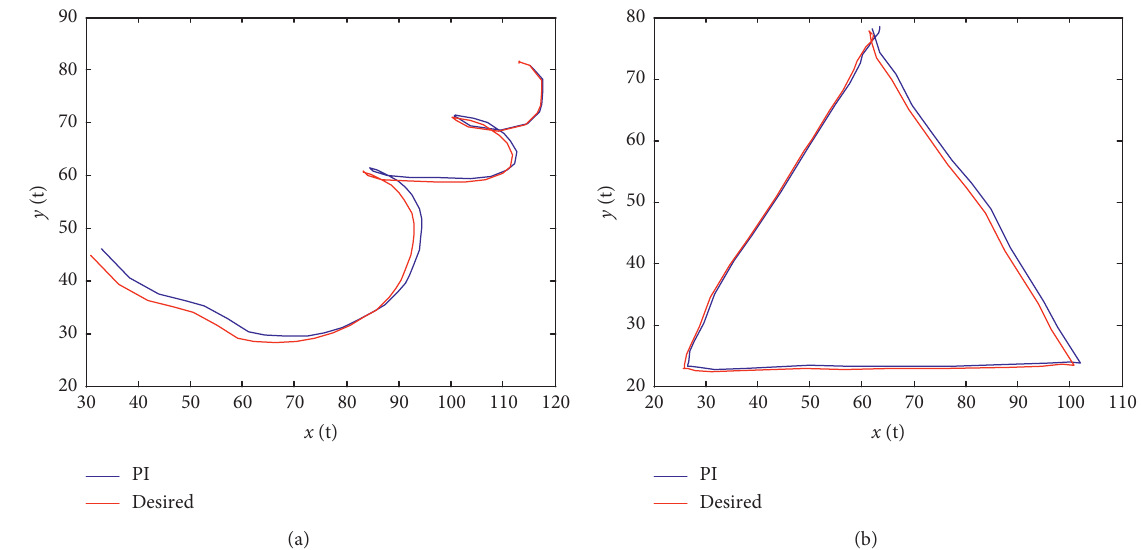
Figure 11: Simulation results for the PI controller applied to (a) Arabic letter “SIN” and (b)